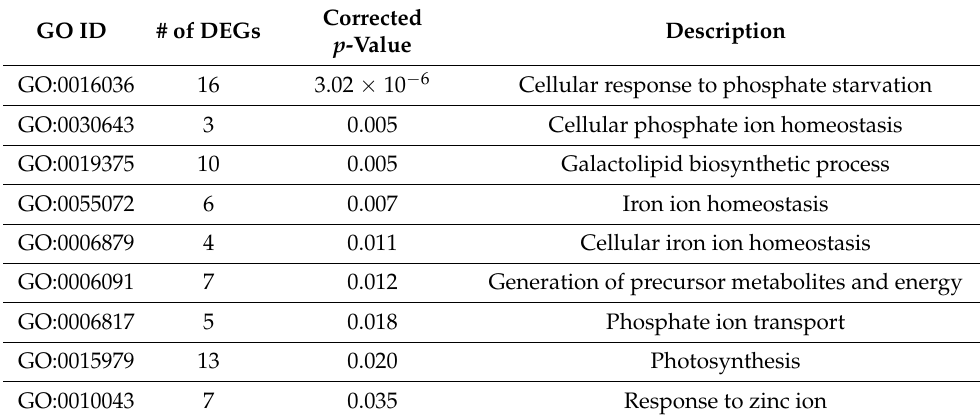
Table 1. Overrepresented biological process Gene Ontology (GO) terms identified in the 228 DEGs identified between VIGS_EV and VIGS_Glyma.05G001700 FeS leaf samples. Corrected p -value was determined after a Fisher’s Exact test followed by a Bonferroni correction to account for repeated